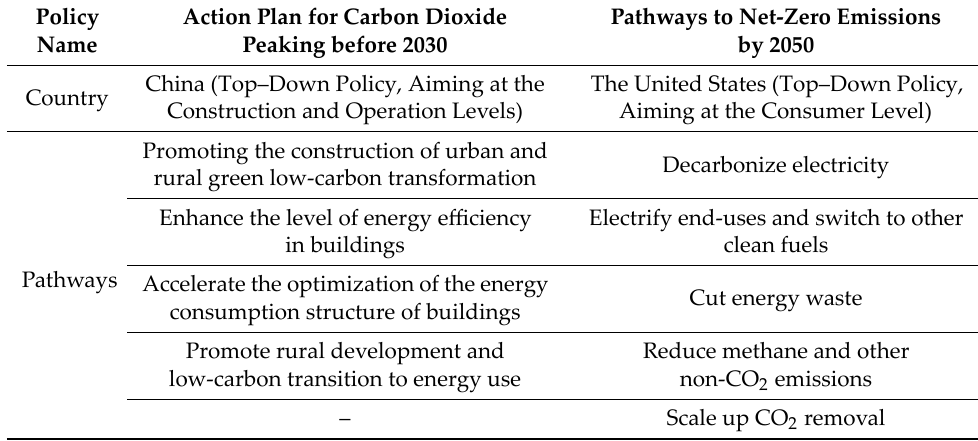
Table 1. Summary of the Chinese Action Plan for Carbon Dioxide Peaking before 2030 and the Path‑ ways to net‑zero emissions by 2050 in the United